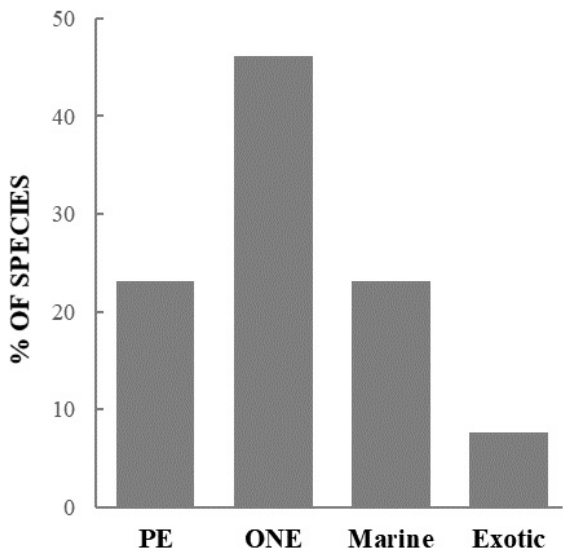
Figure 4 . Number of species of each origin expressed as per- centages of the total of species captured in the lower course of the Negro river drainage. Abbreviations: ONE, other Neotropical ecoregion; PE, native from Patagonia